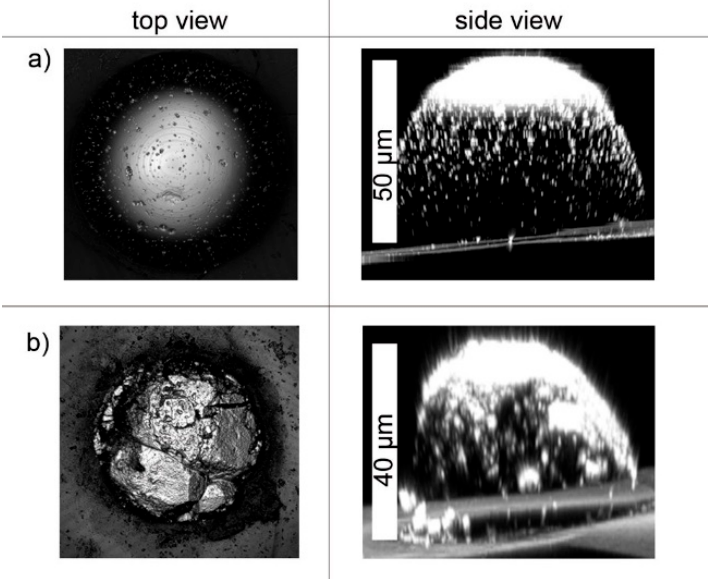
Figure 12. Large conical mercury deposition ( a ) immediately after plating and ( b ) after calibration and nine days of consecutive CSV measurements.